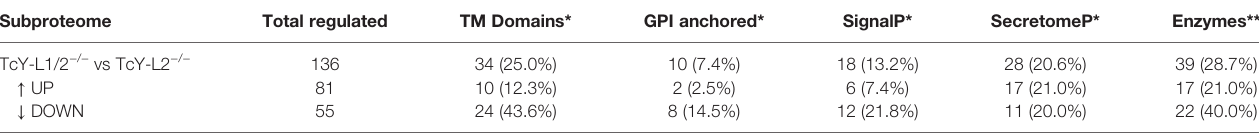
TABLE 3 | Number of proteins from the regulated subproteome with predicted transmembrane domains, GPI-anchor, classically and non-classically secreted, and enzymes. Subproteome